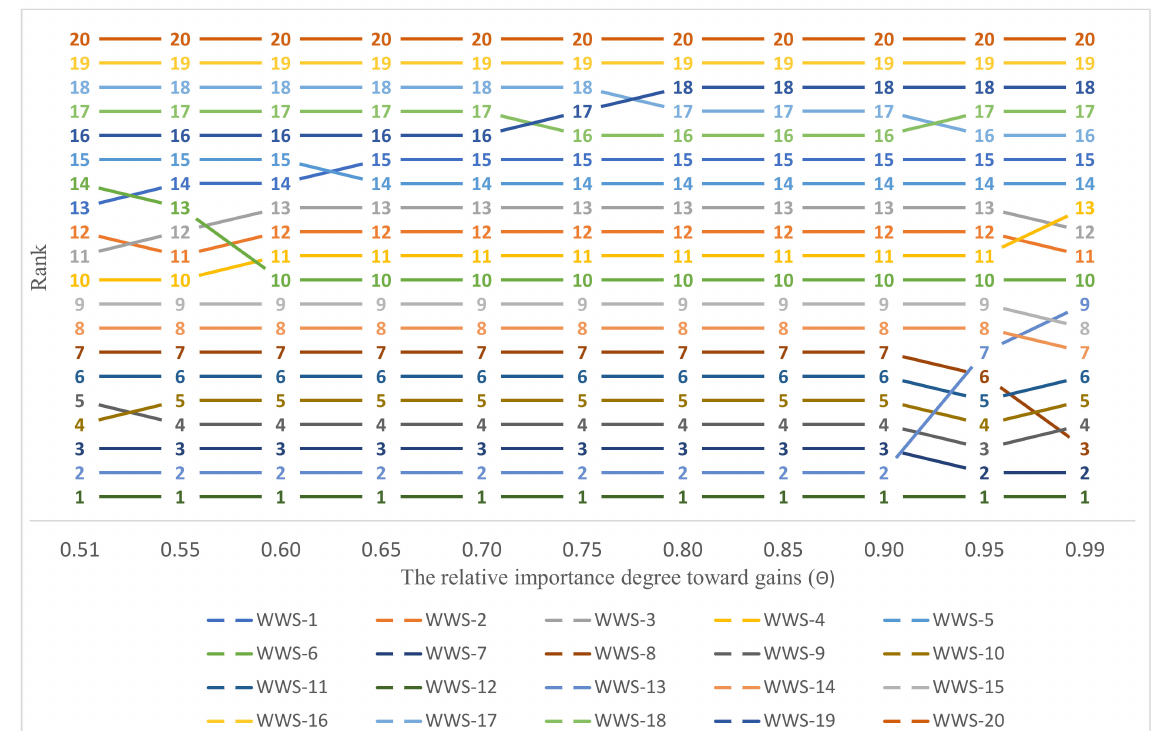
Figure 5. WWS location ranking with different values of Θ